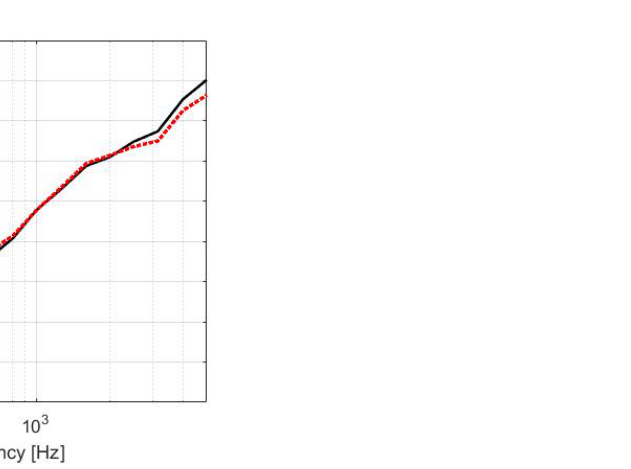
Figure 7. Sound transmission loss TL measured for panel AC-T3-BP filled with polyester and panel AC-T4-BF7 filled with felt.